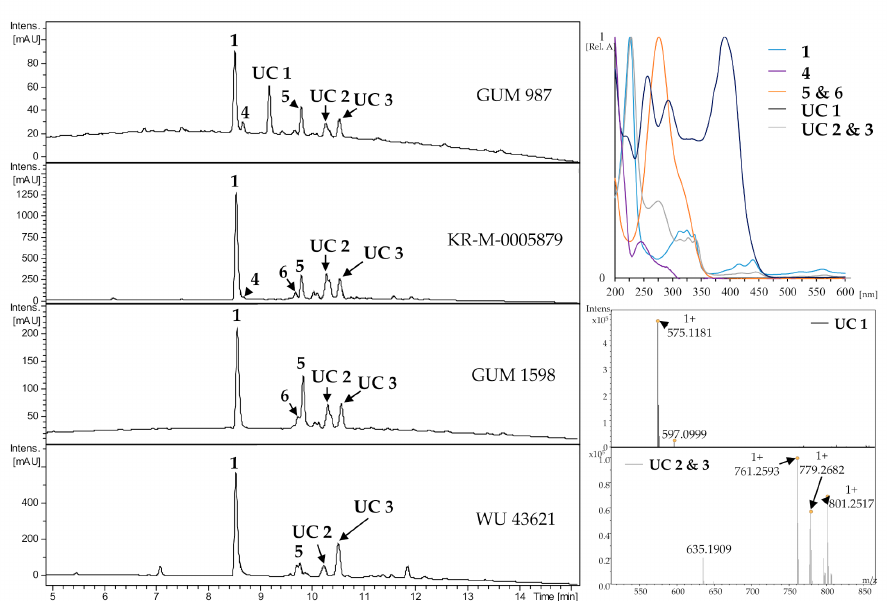
Figure 5. Representative HPLC chromatograms (UV, 210 nm) of stromatal acetone extracts from H. fuscum (WU 43621), H. eurasiaticum (GUM 1598) and H. pseudofuscum (GUM 987 and KR-M-0005879/holotype). UV-Vis chromatograms from 200 to 600 nm and HRESIMS data of unknown compounds of designated peaks are given together with their normalized absorption. UC: Unknown compounds.